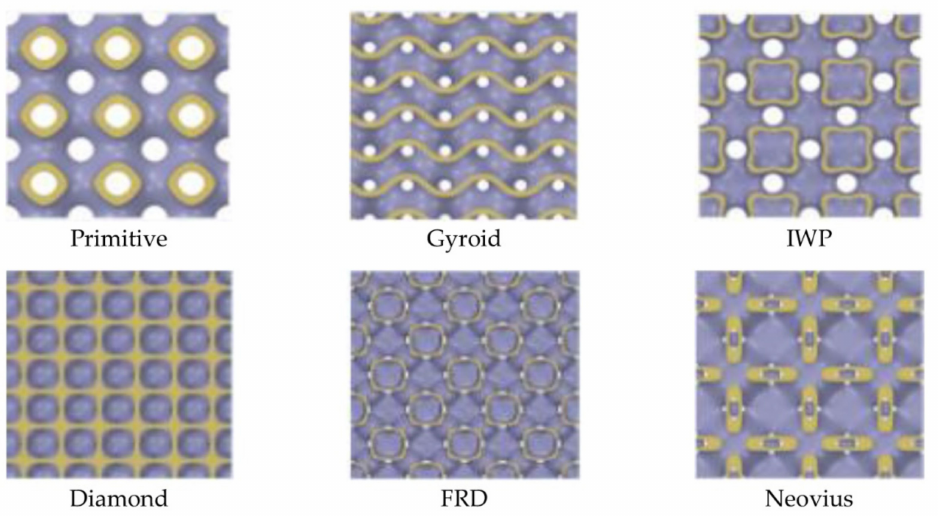
Figure 14. TPMS-membrane contact area of each TPMS structure.